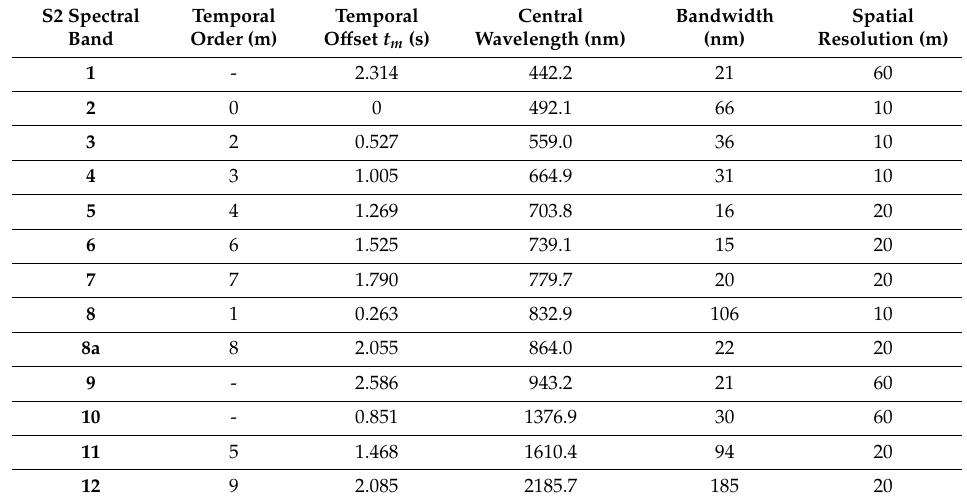
Table 1. Spectral bands for the Sentinel-2B Multispectral Imager. The 10 high resolution bands m = 0, ..., 9 are ordered according to temporal o ff set [1].